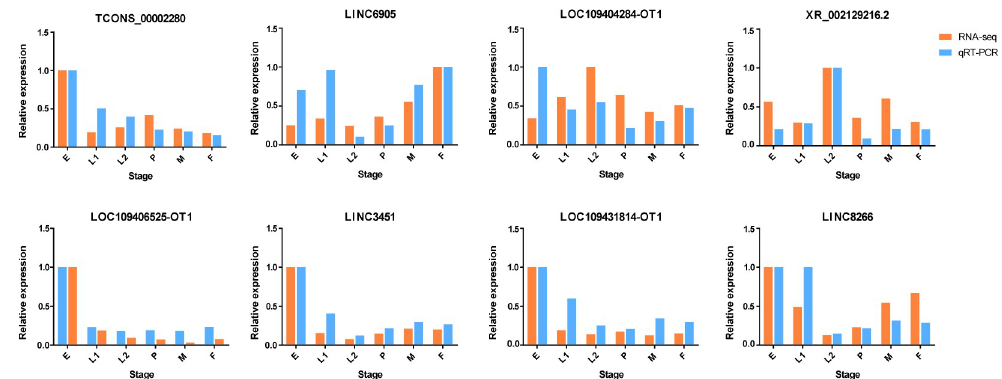
Fig 5. Comparison of expression profiles of eight genes by RNA-Seq and qRT-PCR analyses. Expression levels in eggs were adjusted to 1. The X-axis represented developmental stages, the Y-axis indicated the relative expression of each gene; orange bars were log2 (FPKM+1) values of RNA-Seq and the blue bars were relative expression of qPCR. E, egg; L1, early larvae; L2, late larvae; P, pupae; F, female; M, male.